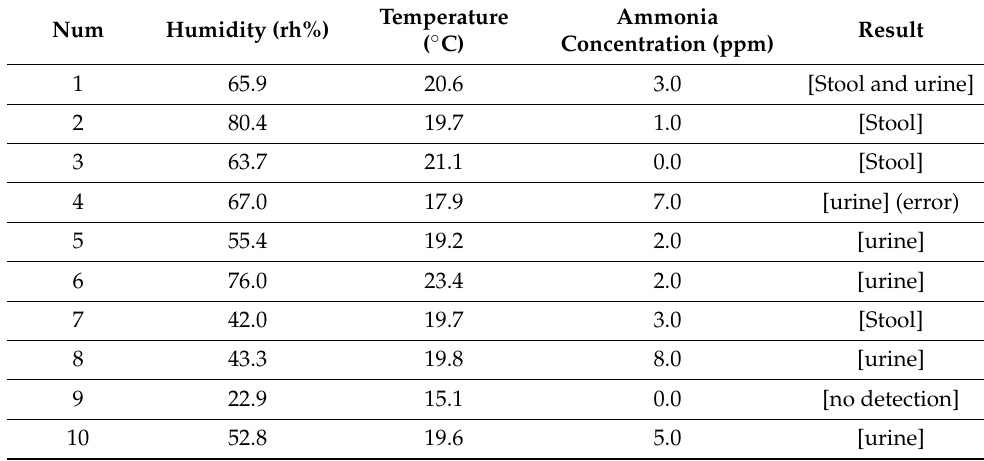
Table 2. D-S evidence theory data fusion